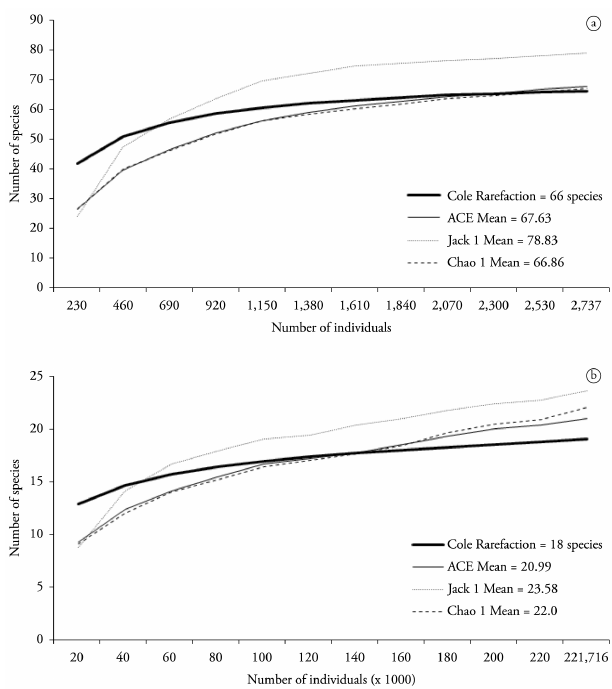
Figure 3. Species accumulation curve (Cole rarefaction) and total richness estimated indexes (ACE mean, Jack 1 mean and Chao 1 mean) of zooplankton from Lake I (a) and Lake II (b) of Clube Caça e Pesca Itororó de Uberlândia, Minas Gerais (2006).